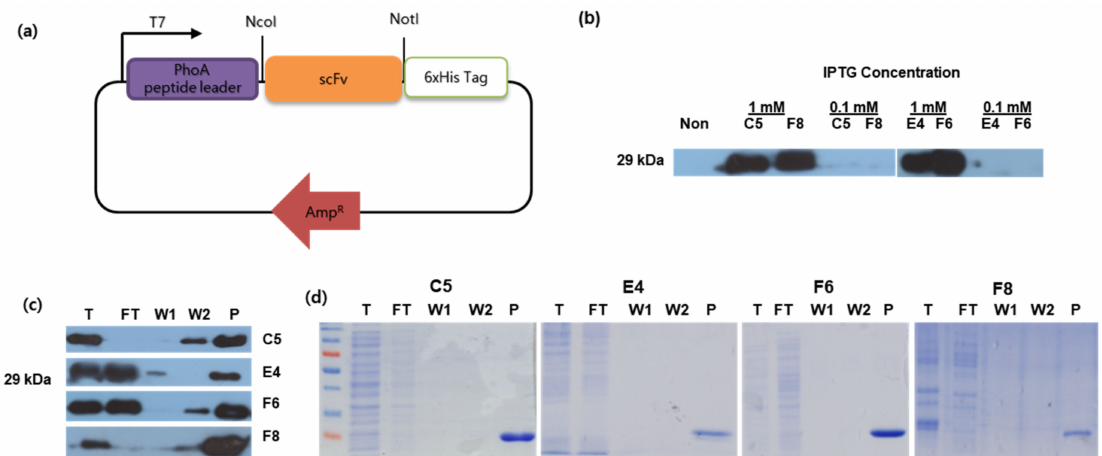
Figure 3. ( a ) Schematic diagram of the pIg20-HisTag vector encoded with an scFv sequence by insertion between the Nco I and Not I sites. This recombinant plasmid was expressed as protein in BL21 pLysE strain bacteria. ( b ) Optimum expression conditions were obtained with 1 mM IPTG induction at 25 ◦ C, which differed significantly from those at 0.1 mM IPTG. Large-scale expression was performed under optimum conditions and the product was purified using CaptoL™ column chromatography with normal gravity. Purification was confirmed by Western blot analysis ( c ) and by SDS-PAGE and Coomassie staining ( d ) with eluate samples from T = Total (filtered media + periplasmic fraction), FT = flow through, W1 = wash 1 elute (binding buffer), W2 = wash 2 elute (citrate/glycine buffer, pH 3.5), P = purified protein (elution buffer). There are no visible impurities in lane P, suggesting that the scFv recombinant protein was purified successfully.